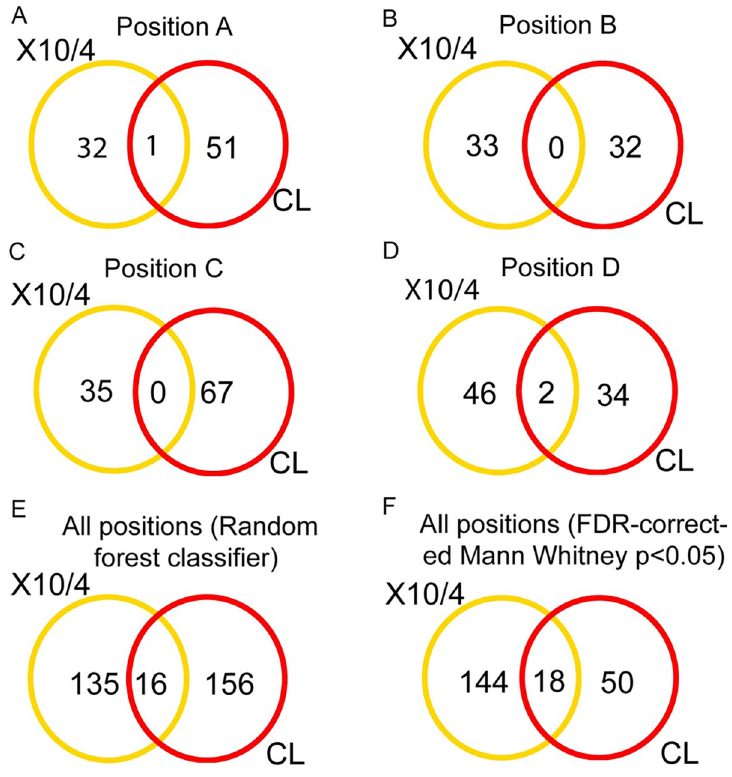
Fig 2. Limited overlap of specific differential metabolites between strains. Yellow and red circles represent differential metabolites between strain Sylvio X10/4-infected and matched uninfected controls, and between strain CL- infected and matched uninfected controls, respectively. Intersect are metabolites impacted by infection in both strains. (A-D) Differential metabolites for each strain, at given heart positions, as determined by random forest classifier, with variable importance score cutoff as described in Methods. (E) Metabolites impacted by infection with each strain, irrespective of position, as determined by random forest classifier, with variable importance score cutoff as described in Methods. (F) Metabolites impacted by infection with each strain, irrespective of heart position, using FDR-corrected Mann Whitney p < 0.05